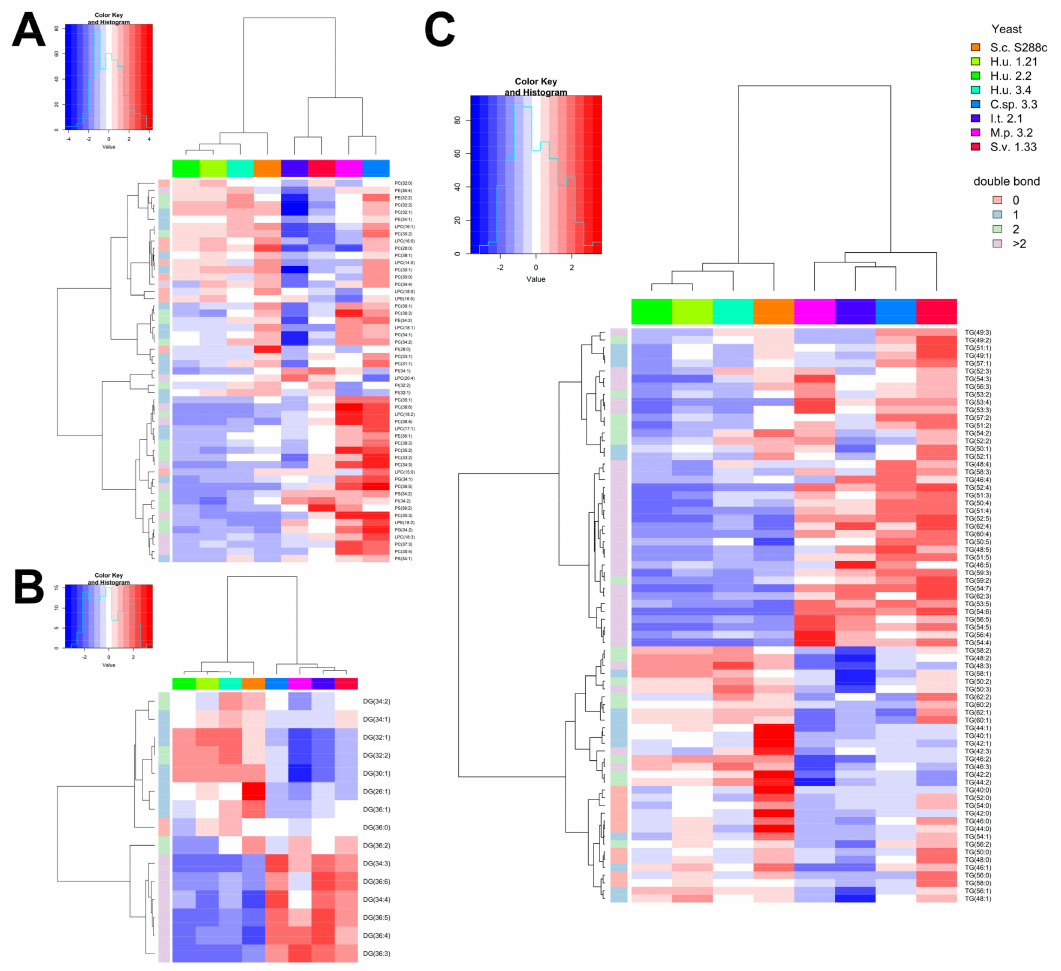
Figure 3. Heatmaps of GPs ( A ), DGs ( B ), and TGs ( C ) in the yeast species and strains included in the study. Intensities of single compounds are displayed using a color scale ranging from red (higher values) to blue (lower values), as shown in the legend. Both rows and columns are clustered using Spearman distance and a Ward clustering algorithm. Average values (n = 6) for each yeast are